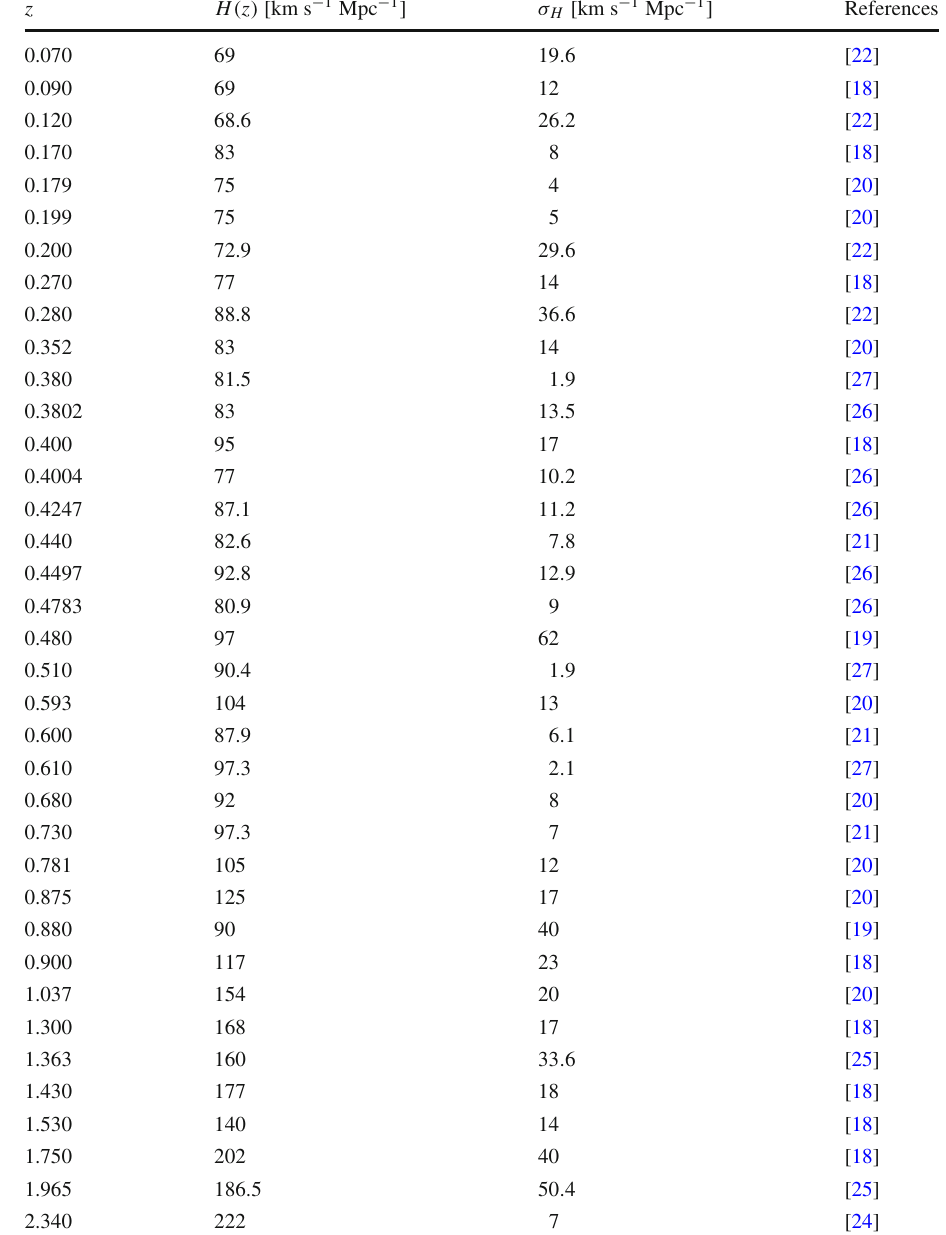
Table 1 Hubble parameter vs. redshift